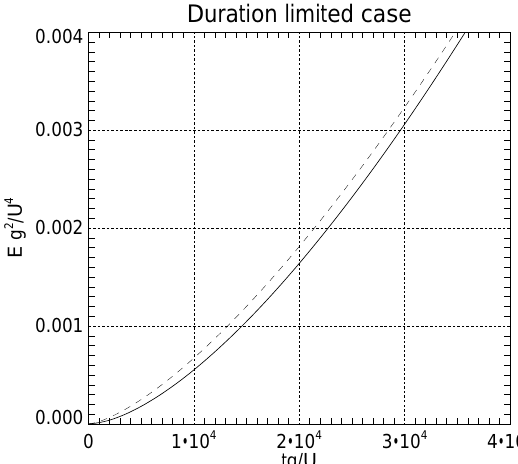
Figure 2. Dimensionless energy Eg 2 /U 4 vs. dimensionless time tg/U for the wind speed U = 10ms − 1 duration limited case – solid line. Self-similar solution with the empirical coefficient in front of it: 1 . 3 × 10 − 9 (tg/U) 10 / 7 – dashed